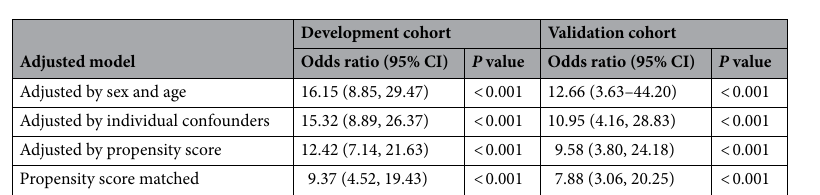
Table 2. Odds ratios associated with tICH expansion, and the presence of multihematoma fuzzy sign in the development cohort and validation cohort.